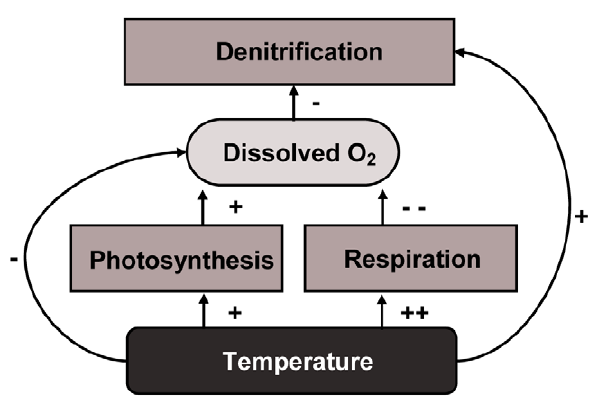
Figure 1. Schematic overview of major direct and indirect effects of temperature on